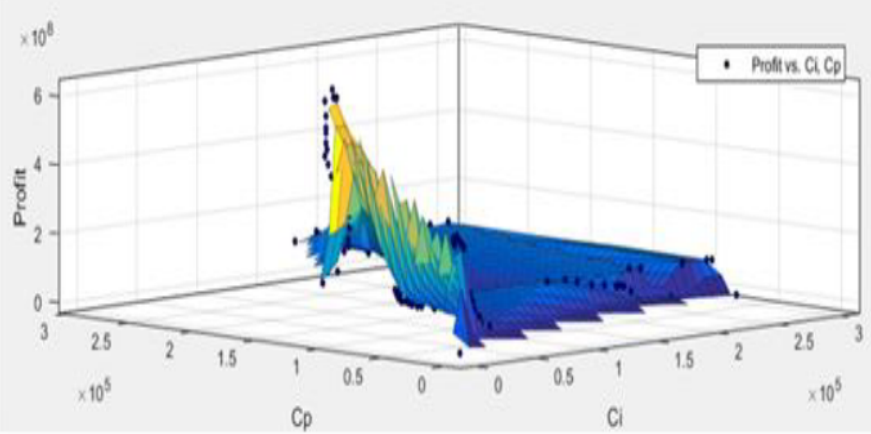
Figure 4. The curves of correlation between idea cost and production cost in active SMES. J. Open Innov. Technol. Mark. Complex. 2020 , 6 , x FOR PEER REVIEW